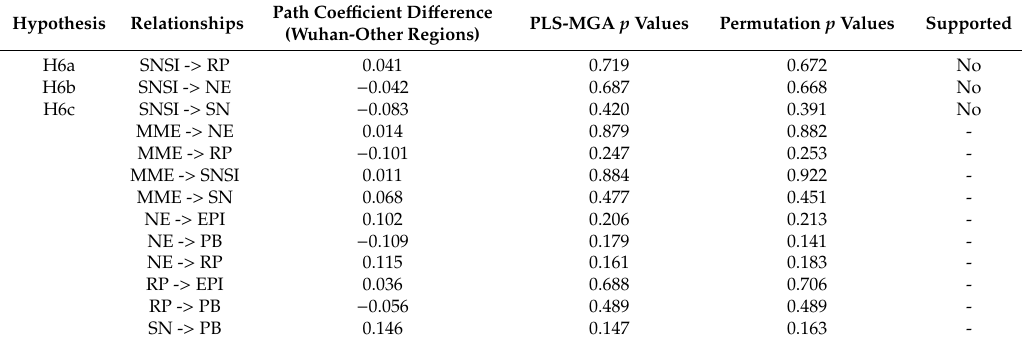
Table 8. Results of MGA.